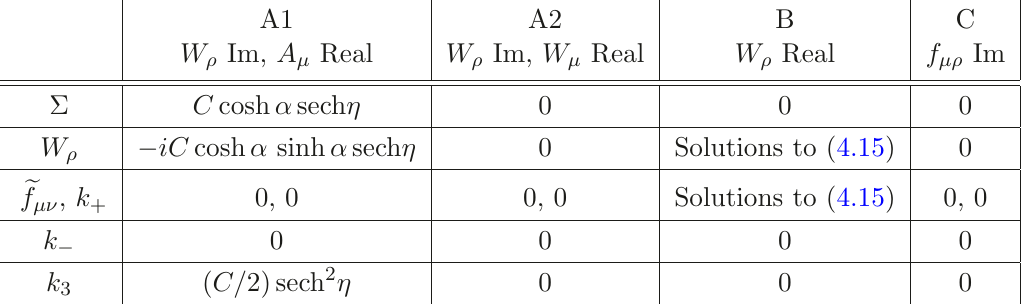
Table 5 . The complete set of off-shell BPS solutions for vector multiplet fluctuations around the near-horizon spinning BH for different reality conditions A and B. As before, f MN is the fluctuation of the field strength of W M , f µν is the fluctuation of the field strength of A µ , Σ is the fluctuation of the scalar σ , and k ± , k 3 are the fluctuations of the auxiliary fields Y ij . For condition B, some e explicit solutions to equations (4.15) are presented in